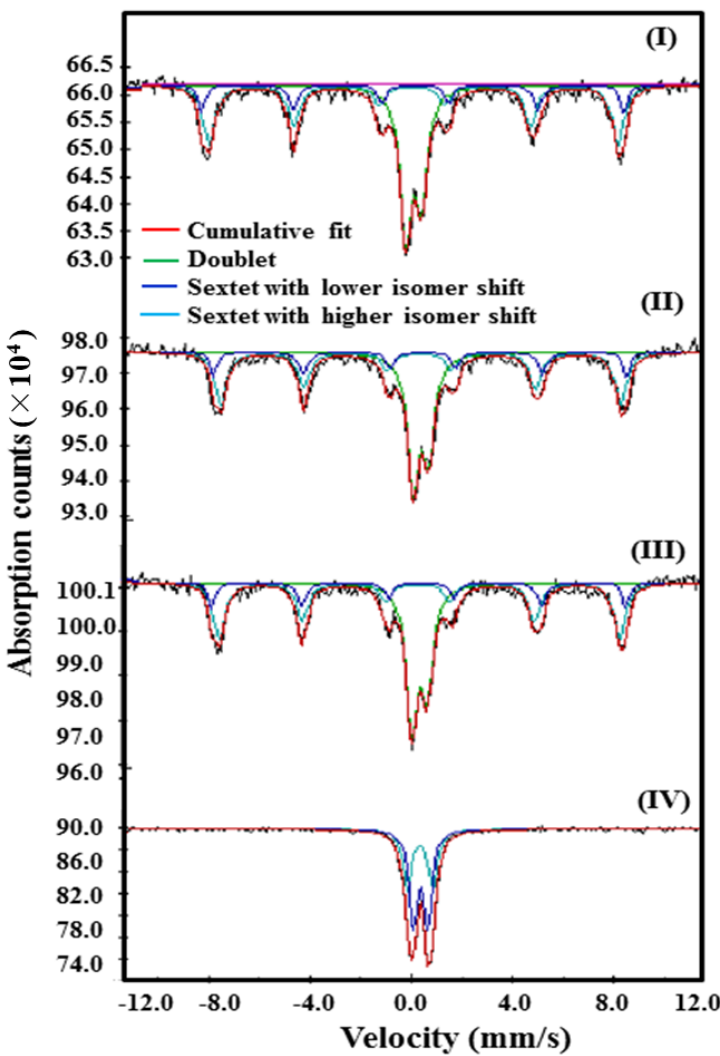
Figure 6. Mössbauer spectra of ( I ) SrFe 2 O 4 , ( II ) Sr 0.7 Ti 0.3 Fe 2 O 4.3 , ( III ) Sr 0.4 Ti 0.6 Fe 2 O 4.6 and ( IV ) TiFe 2 O 5 .